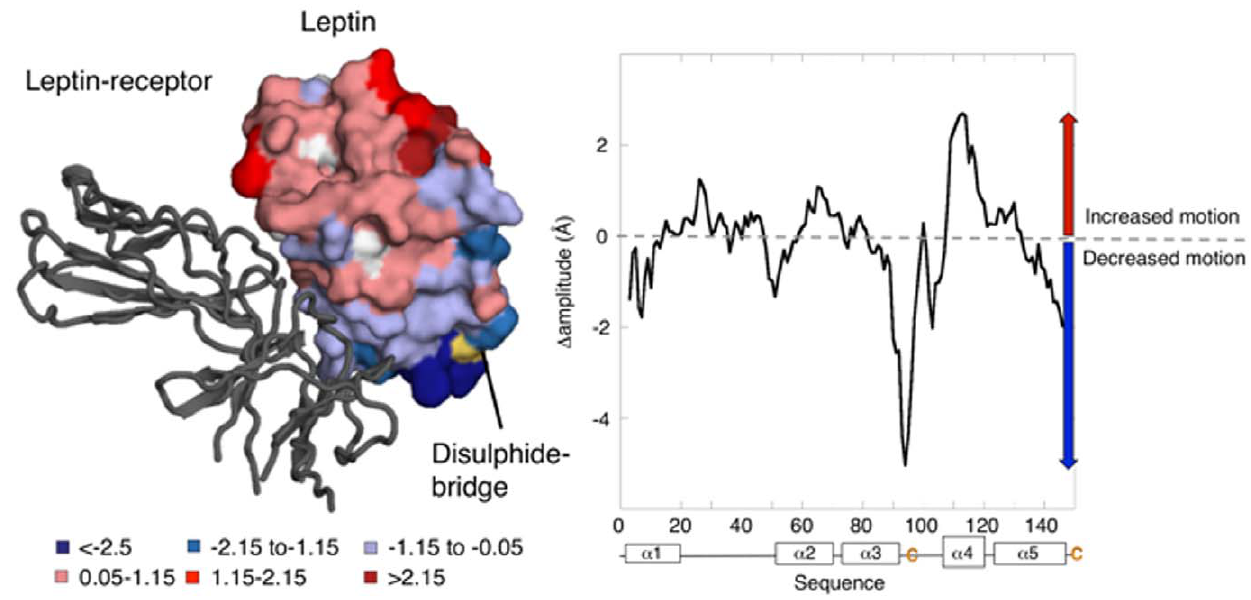
Figure 2. The crystal structure of leptin modeled onto its receptor showing the native state dynamics in the reduced and oxidized state. The results of the dynamic simulations of leptin (PDB code 1AX8) are mapped on to the structure of the receptor complex (PDB code 3V6O). Our analysis of the native state dynamics reveal how the formation of the disulphide bridge changes the native state dynamics from increased motions shown in red to decreased motions shown in blue. The disulphide bridge, indicated in yellow, clearly changes the overall motions in leptin. The plot shows the differences between oxidized and reduced protein where the positive numbers indicates regions with higher dynamics in the oxidized state, while negative numbers indicate higher motions in the reduced state.